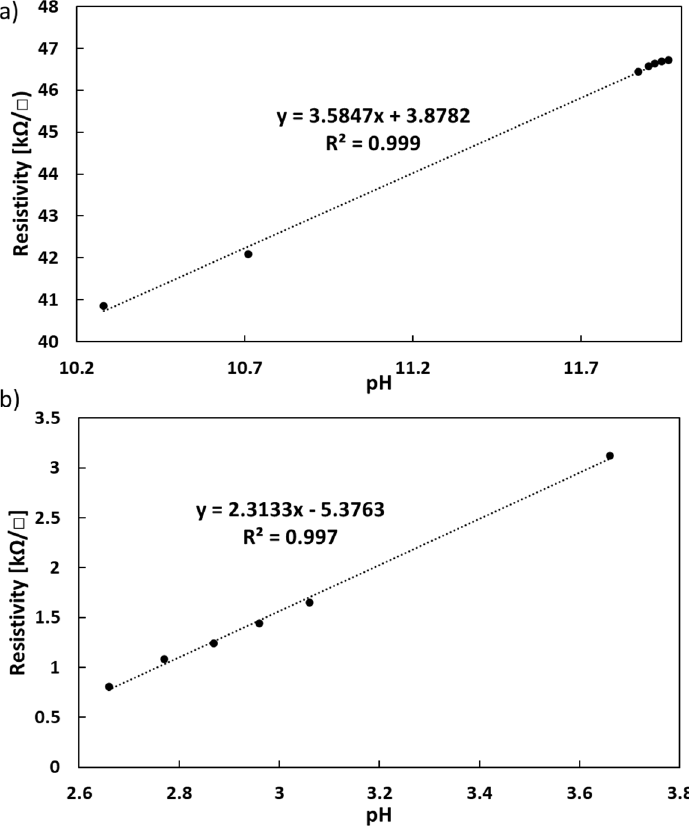
Figure 7. Calibration curve for pH of PANI/MW/P1 film at ( a ) basic and ( b ) acidic pH